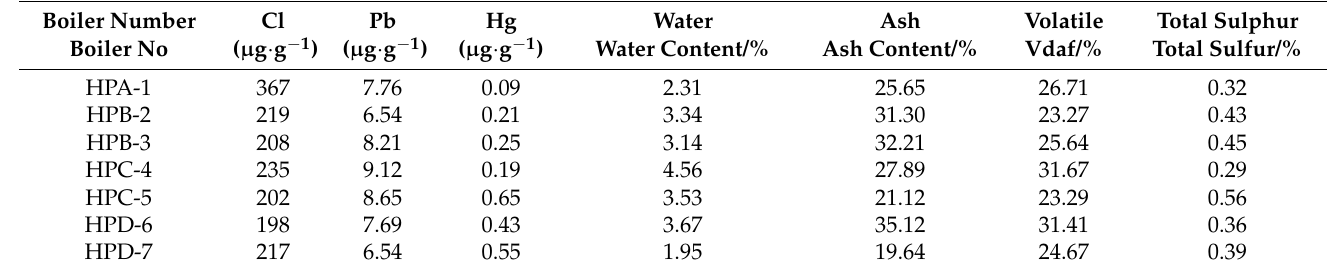
Table 2. Contents of Cl and trace elements in coal.